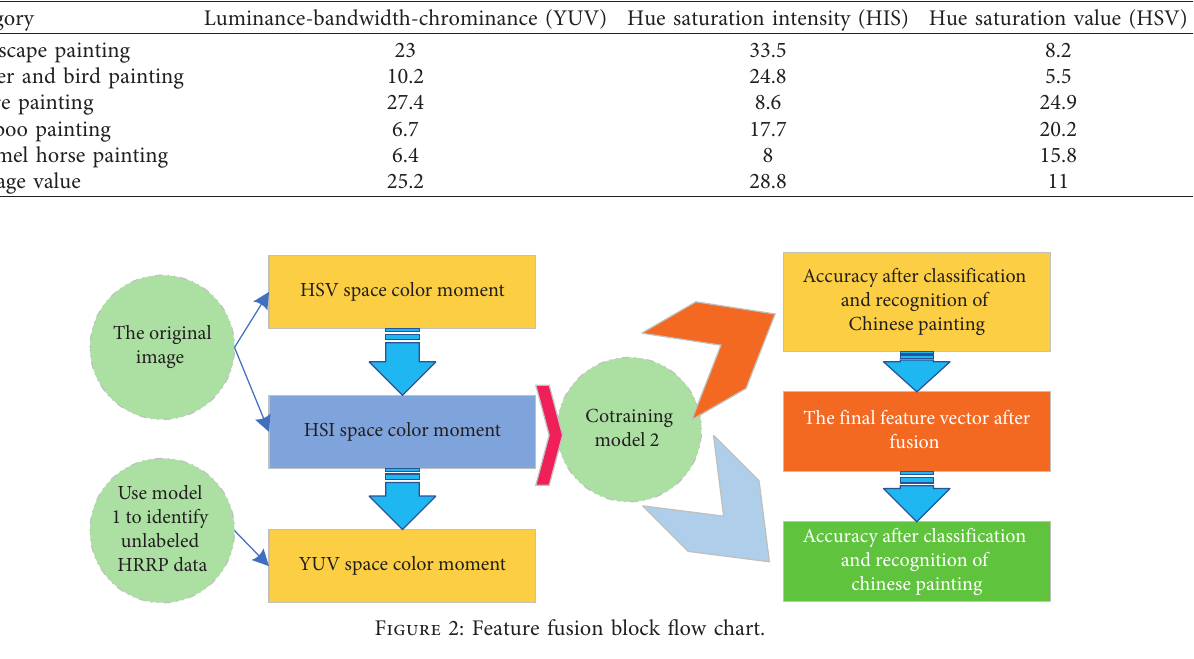
Table 1: Checking rate in different color spaces.